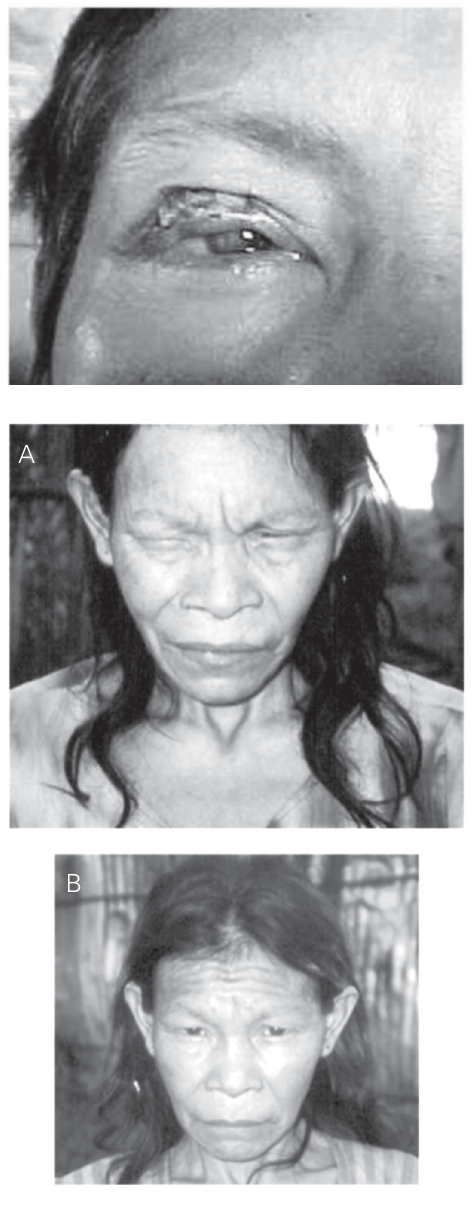
Figure 2. Successful marginal rotation.